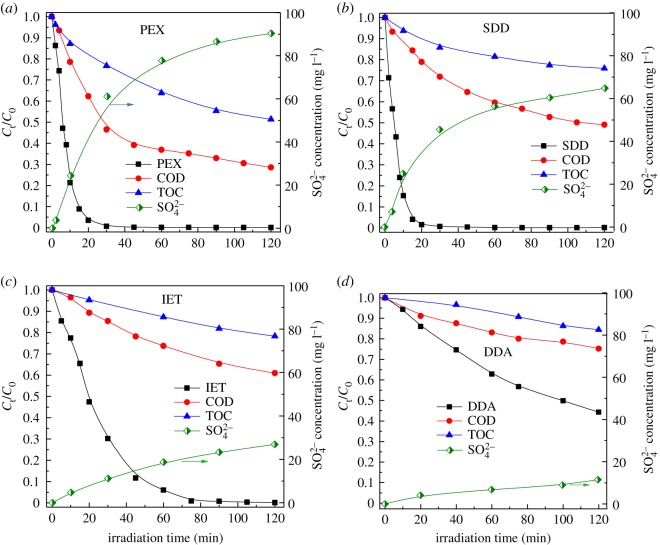
The variations of SO42− concentration and relative concentrations of collector (PEX (a), SDD (b), IET (c) and DDA (d)), COD and TOC with UV185+254 nm irradiation time. Experimental conditions: collector concentration of 100 mg l−1 and initial pH of 10.0.